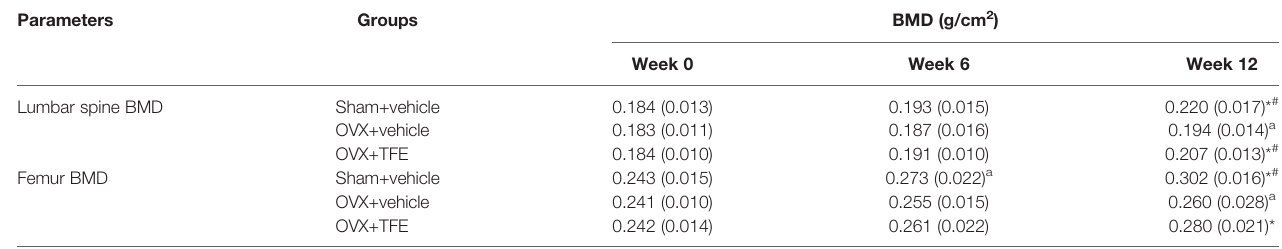
TABLE 2 | Changes in vertebral and femoral BMD in three groups of rats.